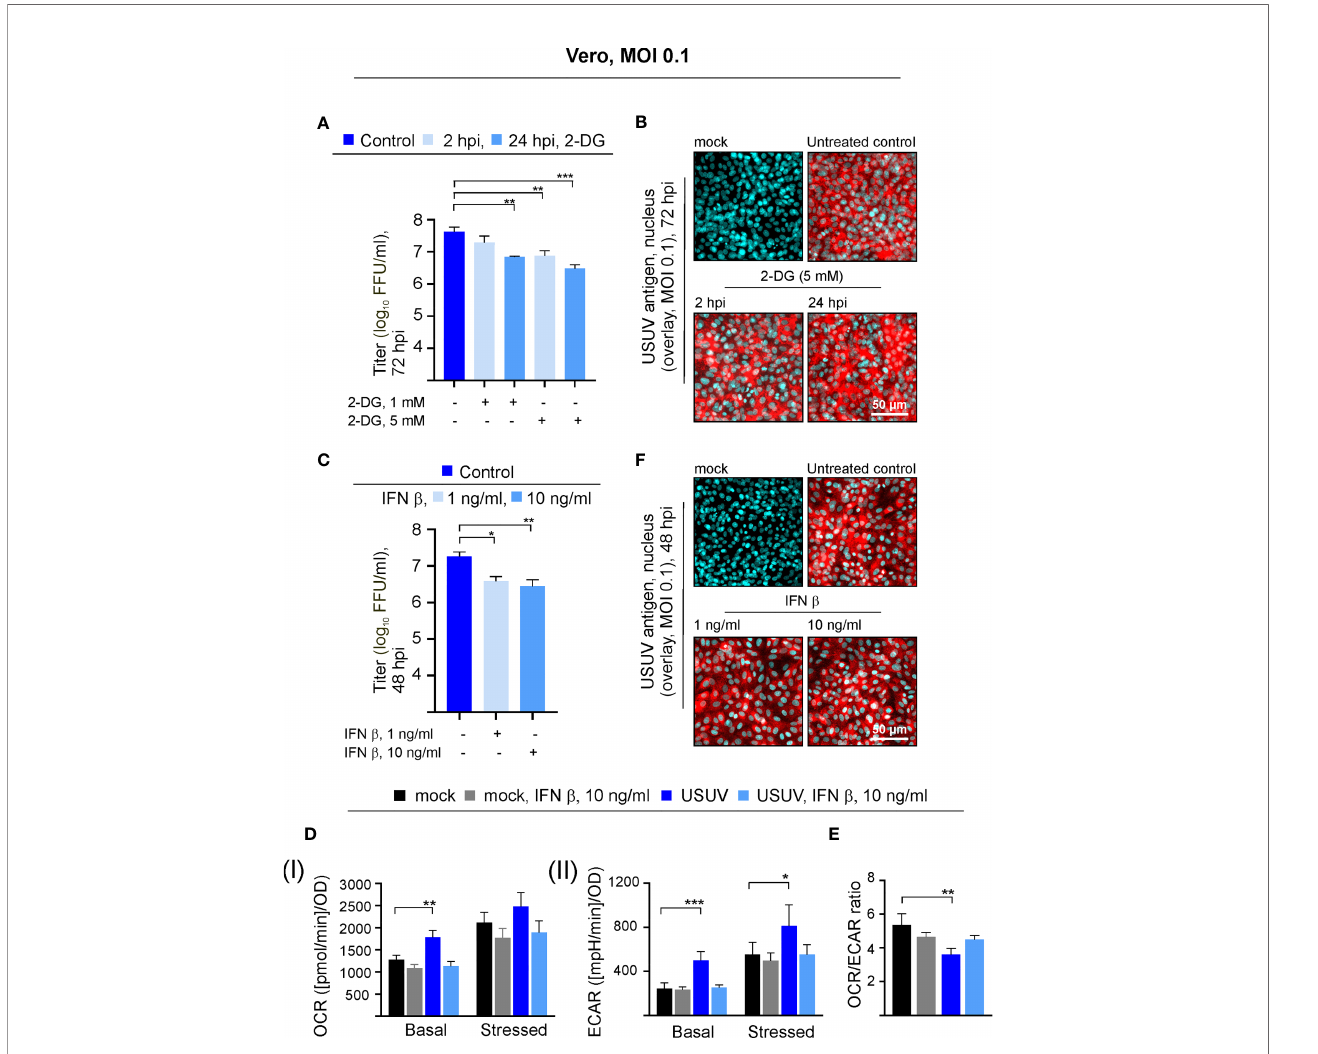
FIGURE 2 | The USUV-associated increase in glycolysis supports USUV yield and is lost in the presence of IFN b . Experiments on Vero cells were conducted at an MOI of 0.1. The dose- and application time point-dependent in fl uence of the glycolysis inhibitor 2-DG on USUV yield was determined by (A) focus-forming assay and (B) immuno fl uorescence analysis of USUV-infected Vero cells with pan- fl avivirus antibodies (shown in red) and nuclear counterstain (shown in blue) at 72 hpi after application of 5 mM 2-DG at 2 and 24 hpi. The impact of 1 and 10 ng/ml IFN b applied at 24 hpi to USUV-infected Vero cells was analyzed at 48 hpi by focus- forming assay (C) and immuno fl uorescence analysis (F) . (D) At 48 hpi basal and stressed (I) OCR and (II) ECAR values were determined through extracellular fl ux measurements with the cell phenotype test kit under basal and stressed conditions (co-application of 0.8 µM FCCP and 1 µM oligomycin) in the presence of 10 ng/ ml IFN b applied at 24 hpi. (E) OCR/ECAR ratio was calculated based on basal OCR and ECAR as determined at measurement point 3 of extracellular fl ux measurements. (A, C – E) Data (n = 3) are shown as mean ± SD involving statistical analysis for (A, C) in comparison to solvent control-treated samples and (D, E) in comparison to the mock-infected control performed by ANOVA and Dunnett ’ s post-hoc multiple comparisons test. Statistical signi fi cance is calculated as *p < 0.05), **p < 0.01, and ***p <